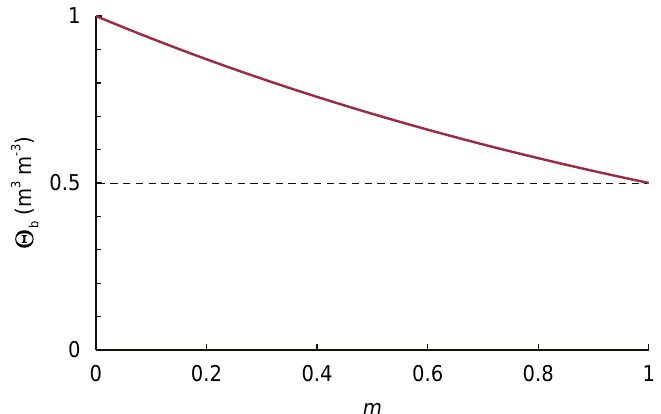
Figure 2. Effective saturation Q b as a function of the Van Genuchten parameter m , assuming parameter a to be the inverse of the air-entry pressure.